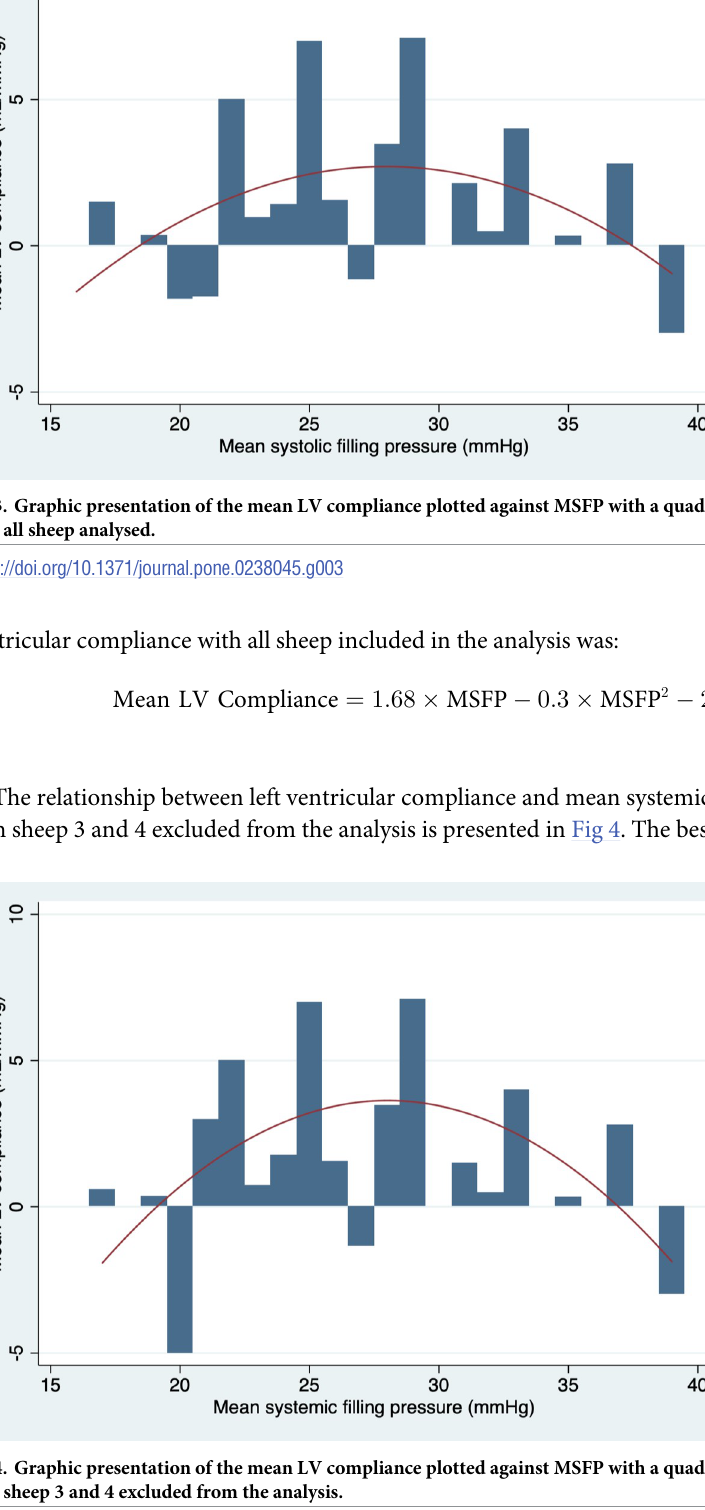
Fig 4. Graphic presentation of the mean LV compliance plotted against MSFP with a quadratic line of best fit with sheep 3 and 4 excluded from the analysis.